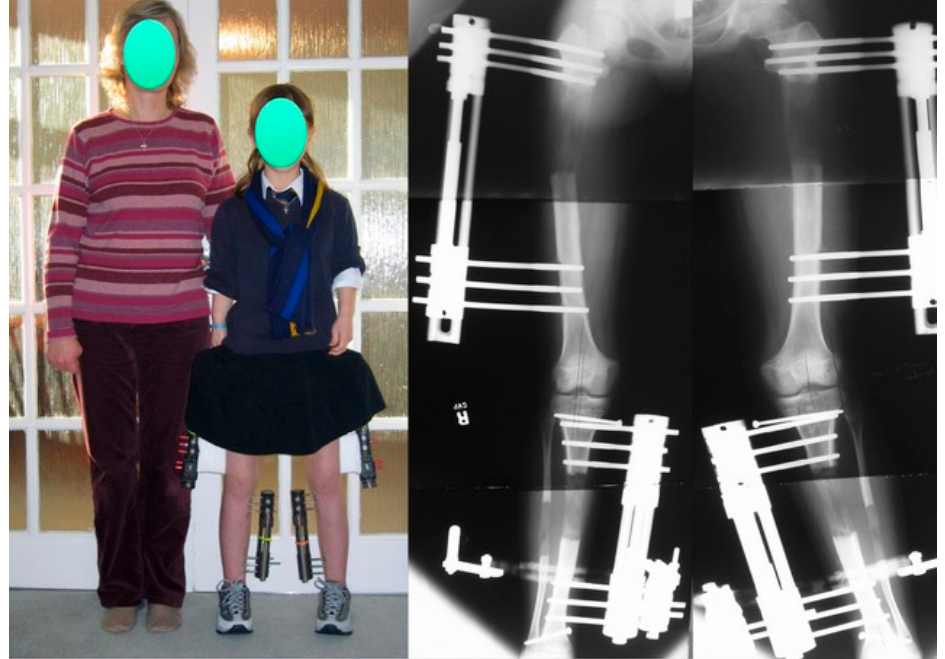
Figure 4. Achondroplastic girl standing next to her mother during the second of three juvenile-onset lower-limb 4-segment lengthenings. The 4 monolateral fixators are clearly visible. The radiograph to the right shows an 8 cm gain in the femurs and a 7 cm gain in the tibia-fibula.